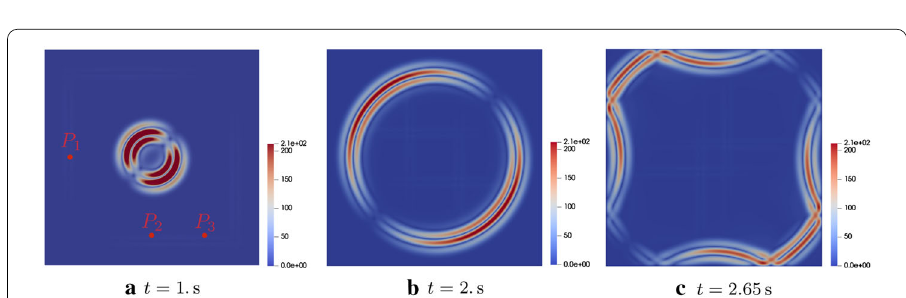
Fig. 5 Elastic wave propagation in a homogeneous isotropic medium (absolute value of the acceleration field)